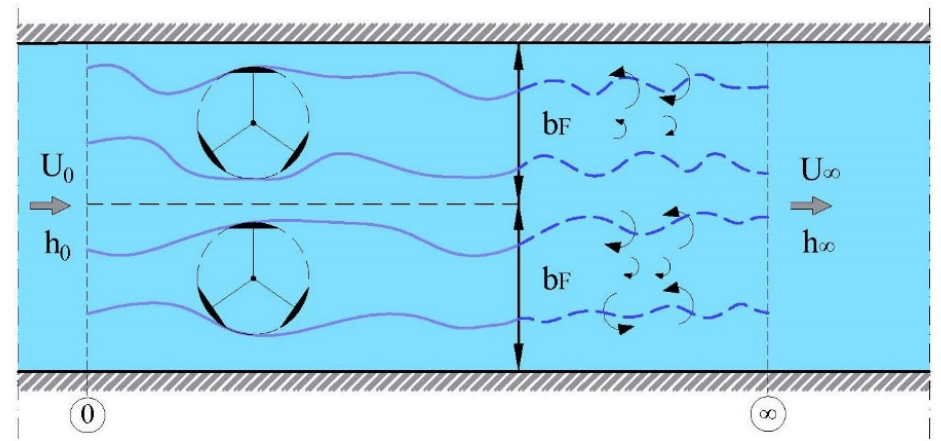
Figure 3. Control volume of an array of aligned HK turbines in a channel flow.